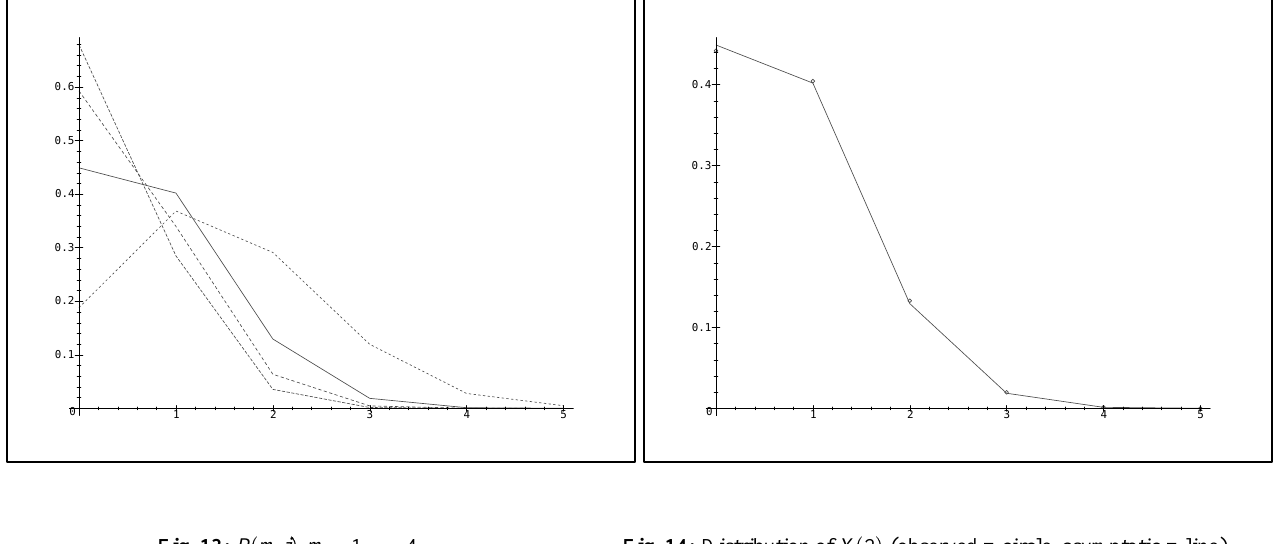
Fig. 13: P (cid:1) m i (cid:3)(cid:2) m (cid:0) 1 4 Fig. 14: Distribution of X (cid:1) 2 (cid:3) (observed = circle, asymptotic = line) (cid:2) (cid:2)(cid:0)(cid:0)(cid:0)(cid:2)